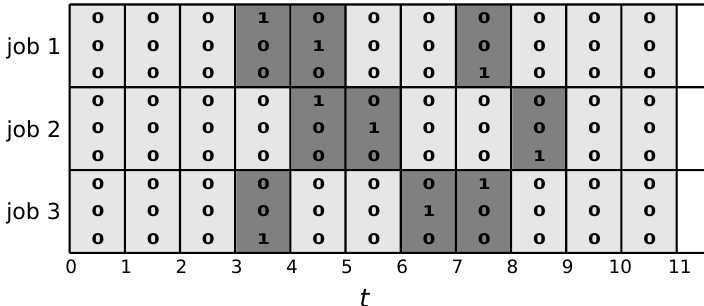
Figure 4. This example considers the same toy instance, as in Figure 2, in which three jobs have to execute on three machines. The variable values (with respect to Model 1) are indicated for the same three solutions as those displayed in Figure